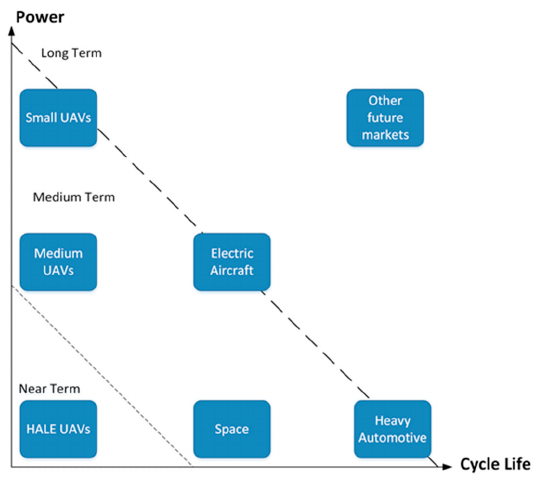
Figure 6. Li-S cell applications versus improvements to power, cycle life and timescale.